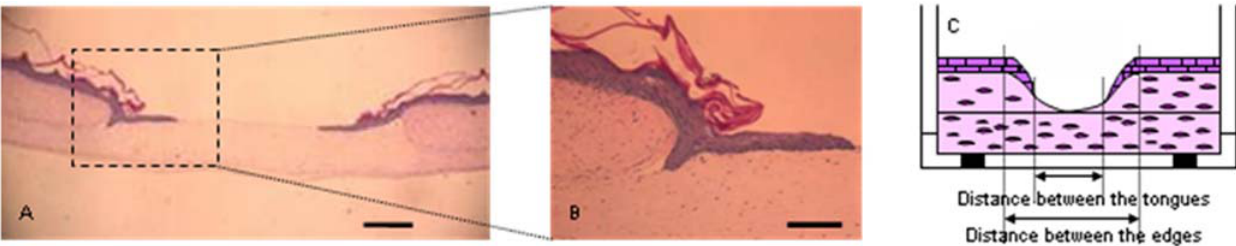
Figure 4. Hematoxylin and Eosin staining of wounds (A,B) shows epithelial tongues migrating across the wound bed to close the wound. C is a schematic figure of the wound. The distance between the wound edges and between the epithelial tongues is measured to determine the